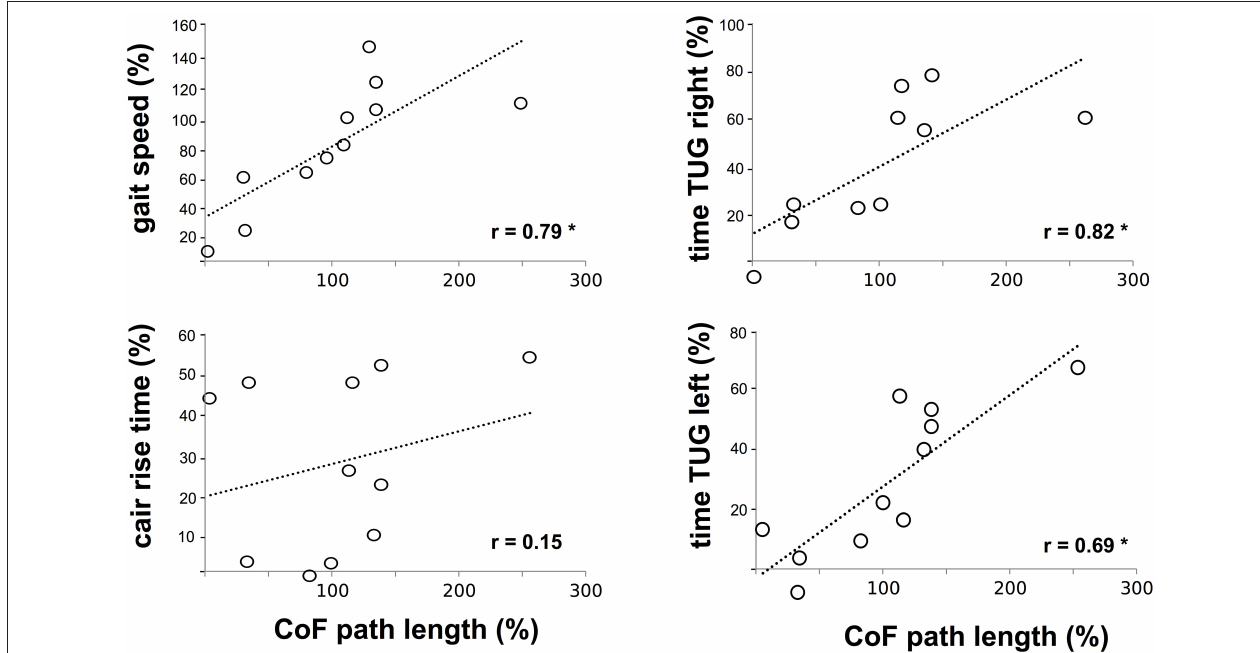
FIGURE 5 | Interrelation between deficits in posture control, gait and functional mobility: Pearson’s correlation coefficients among the variables center of force (CoF) path length (abscissa) with the gait speed, chair-rising time (left ordinate) and time to accomplish the Timed Up and Go (TUG) test (right ordinate) for the CTRL calculated for differences between values at R + 1 and BDC-1. Findings revealed positive correlations indicating an interrelationship between the decline in posture control and the slowdown in gait and TUG speed. *indicates significant